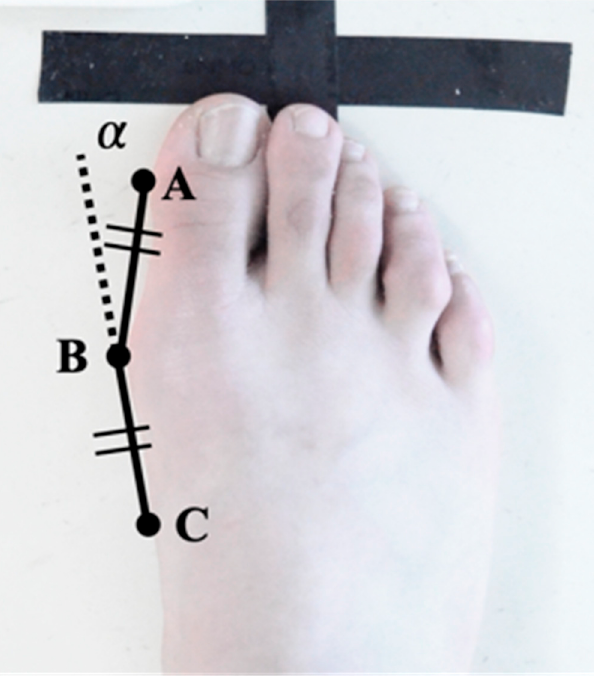
Figure 2. Measurement method for the hallux valgus angle.